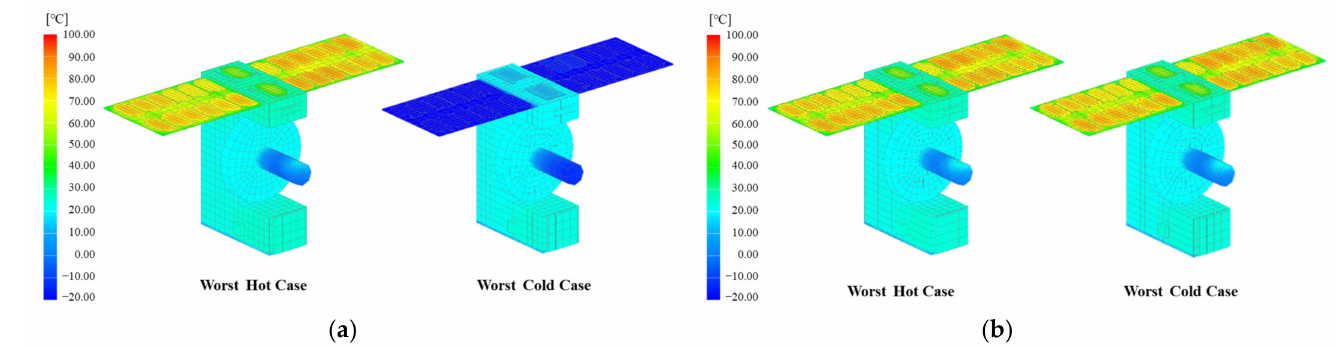
Figure 20. Exterior temperature contours of on-orbit thermal analysis for worst hottest and coldest case. The worst hottest case is for maximum solar flux and internal heat loads. The worst coldest case is for minimum solar flux and internal heat loads: ( a ) solar irradiance conditions for the summer season which have eclipse periods; ( b ) solar irradiance conditions without eclipse periods. Table 11. Summary of thermal analysis results for worst hottest and coldest cases.